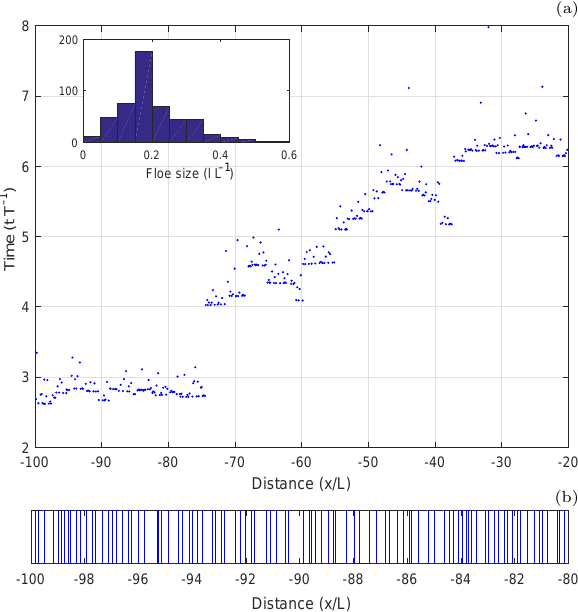
Figure 14. Wave-induced breaking of an ice floe with initial size 100 L , “frozen” at its right end ( x = 0). In the main panel in (a) , individual breaking events are shown with dots in function of their position and time. The inset in (a) shows the histogram of the floe sizes ( l/L ) after breaking. In (b) , a fragment of the initial floe, 20 L long, is shown, with breaking positions marked with vertical lines.